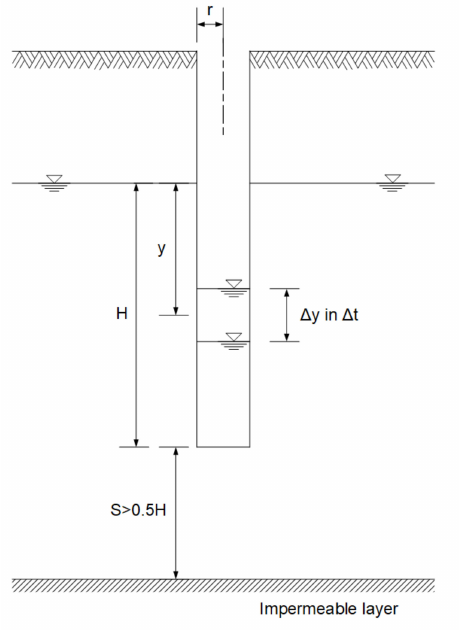
Figure 4. Schematic of the auger hole method. (r = radius of the hole, H = depth of the hole below the groundwater table, y = distance between the groundwater table and the average water level in the hole for a given time ∆ t, ∆ y = water level change in the hole for a given time ∆ t, and S = distance from the bottom of the hole to the impermeable